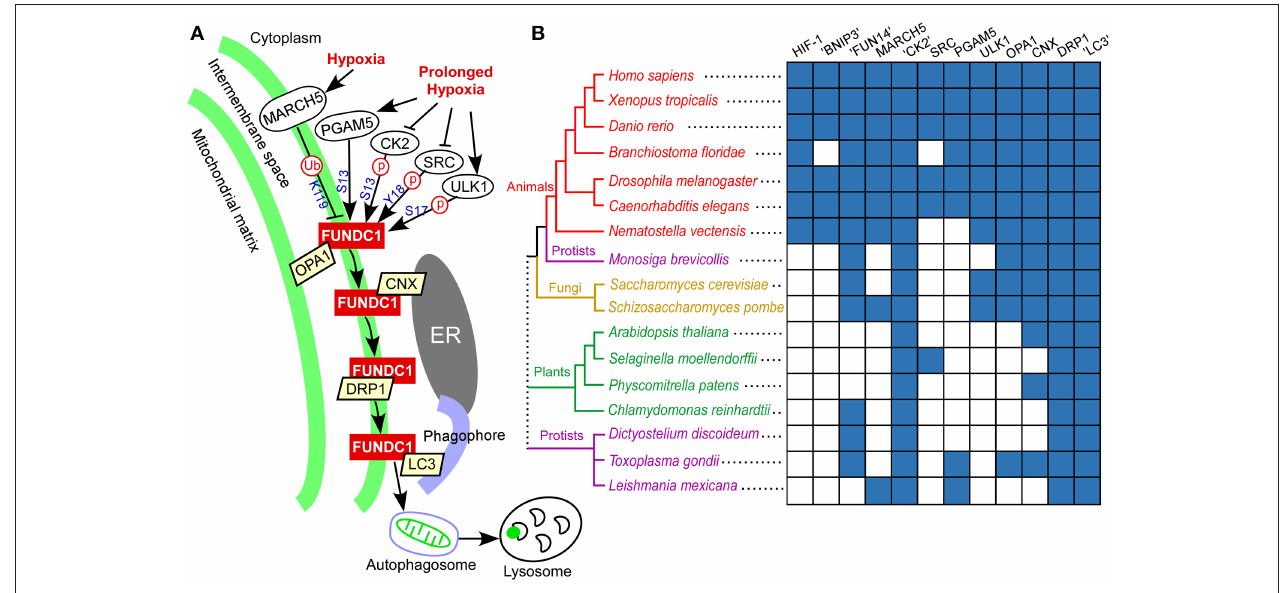
FIGURE 6 | FUNDC1 pathway in response to hypoxia and phylogenetic profiles of genes in this pathway. (A) Model of FUNDC1 pathway for mitochondrial fission and mitophagy in response to hypoxia in mammalian cells. Under normal (unstressed) conditions, FUNDC1 interacts with OPA1, a mitochondrial fusion protein in the intermembrane space ( Chen et al., 2016), and is inactivated by phosphorylation at S13 by CK2 and at Y18 by SRC kinase (Liu et al., 2012; Chen et al., 2014). The initial hypoxic stress increases the interaction between MARCH5 and FUNDC1, leading to FUNDC1 ubiquitylation at K119 and degradation. Degradation of FUNDC1 by MARCH5 desensitizes mitochondria to hypoxia-induced mitophagy. Under prolonged hypoxic conditions, OPA1, CK2, and SRC kinase dissociate from FUNDC1. Dephosphorylation at Y18 plays a critical role in reactivating the FUNDC1-mediated mitophagy (Kuang et al., 2016). The PGAM5-mediated dephosphorylation at S13 (Chen et al., 2014) and ULK1-mediated phosphorylation at S17 (Wu et al., 2014) add additional regulations. At the early stage of hypoxia, FUNDC1 increasingly accumulates in the mitochondrion associated membrane and interacts with the endoplasmic reticulum protein calnexin (CNX). As mitophagy proceeds, FUNDC1 dissociates from calnexin, binds to DRP1 in the mitochondrion associated membrane and triggers mitochondrial fission ( Wu et al., 2016). Finally, FUNDC1 binds to LC3 on the phagophore, thereby aiding engulfment of the defective mitochondrion in an autophagosome. The autophagosome then fuses with lysosomes to allow degradation and recycling of mitochondria to occur. (B) Distribution of human genes in the FUNDC1 pathway as well as two other mitophagy receptors (NIX and BNIP3) and their transcription factor (HIF-1 α ) (listed on the top) under hypoxia in a representative group of fully sequenced eukaryotic genomes (on the left). “CK2” includes CK2 catalytic subunits ( α 1 and α 2). “LC3” includes LC3 and related members of the GABARAP family. “FUN14” and “BNIP3” were respectively identified using a HMM-based search of the FUN14 domain and BNIP3 domain. DRP1 and OPA1 were identified and classified according to the phylogenetic analysis of dynamin domain-containing proteins (i.e., dynamin superfamily) (Supplementary Figure 4). Other gene families were identified using a modified bidirectional BLASTP method (see Materials and Methods). The presence of a homolog of a human gene family in a particular species is in blue, and the lack of an apparent homolog is in white. A consensus cladogram showing the topology (branch lengths are not intended to be to scale) of the phylogenetic relationships between the species is displayed. Colored branches and nodes indicate membership in different major lineages of the tree. The dotted line joining the major branches indicates an unclear phylogenetic